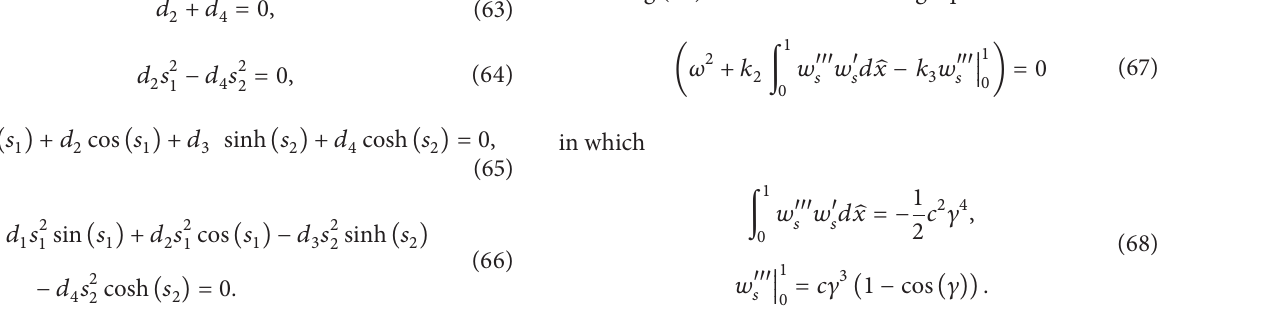
6.2. Simply Supported-Simply Supported End